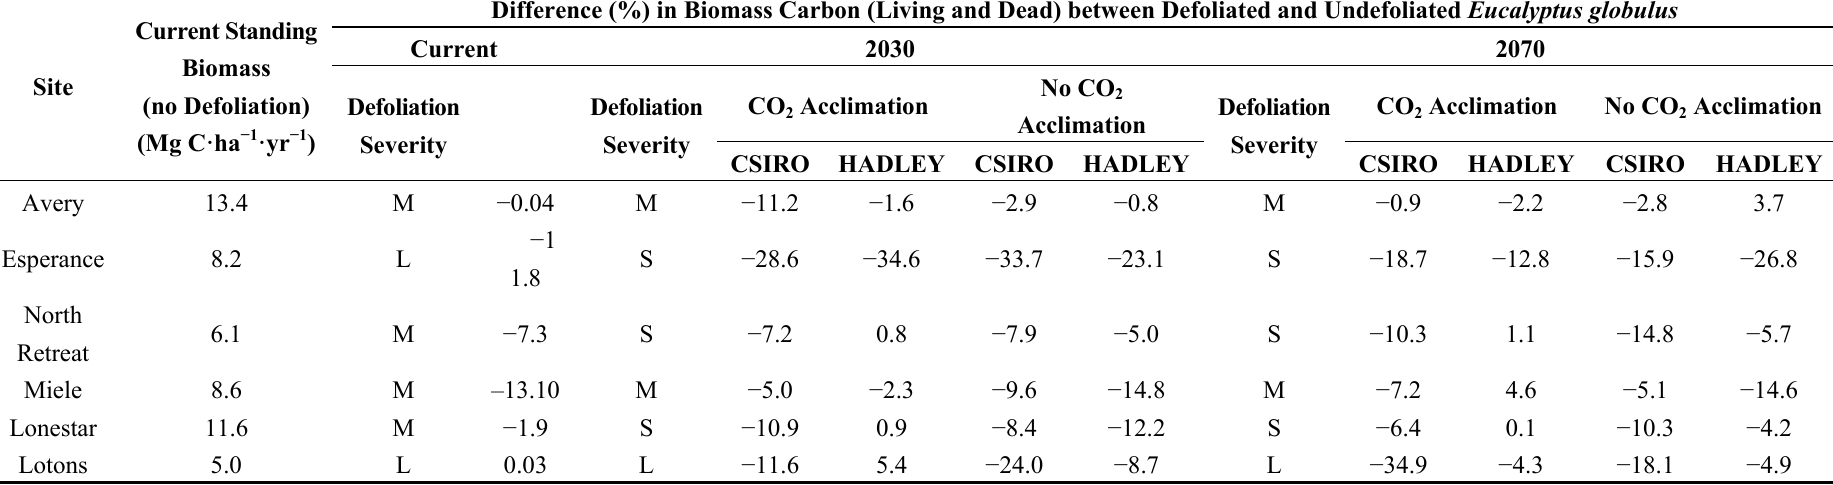
Table 3. Difference (%) in biomass carbon (living and dead) between defoliated and undefoliated Eucalyptus globulus growing at six sites in southern Australia. Estimates are presented for a stand age of 10 years, for the two climate models (CSIRO and Hadley) for current, 2030 and 2070 conditions, and assuming either photosynthetic acclimation to elevated CO The defoliation levels are those predicted for each site and climate scenario using CLIMEX, whereby L = 10%–30% leaf loss and 20% frequency of years affected; M = 40%–60% leaf loss and 60% frequency of years affected; and S = 60%–80% leaf loss and80% frequency of years affected (see Table 2). Defoliation impacts were modelled in 10% defoliation increments in each severity class and